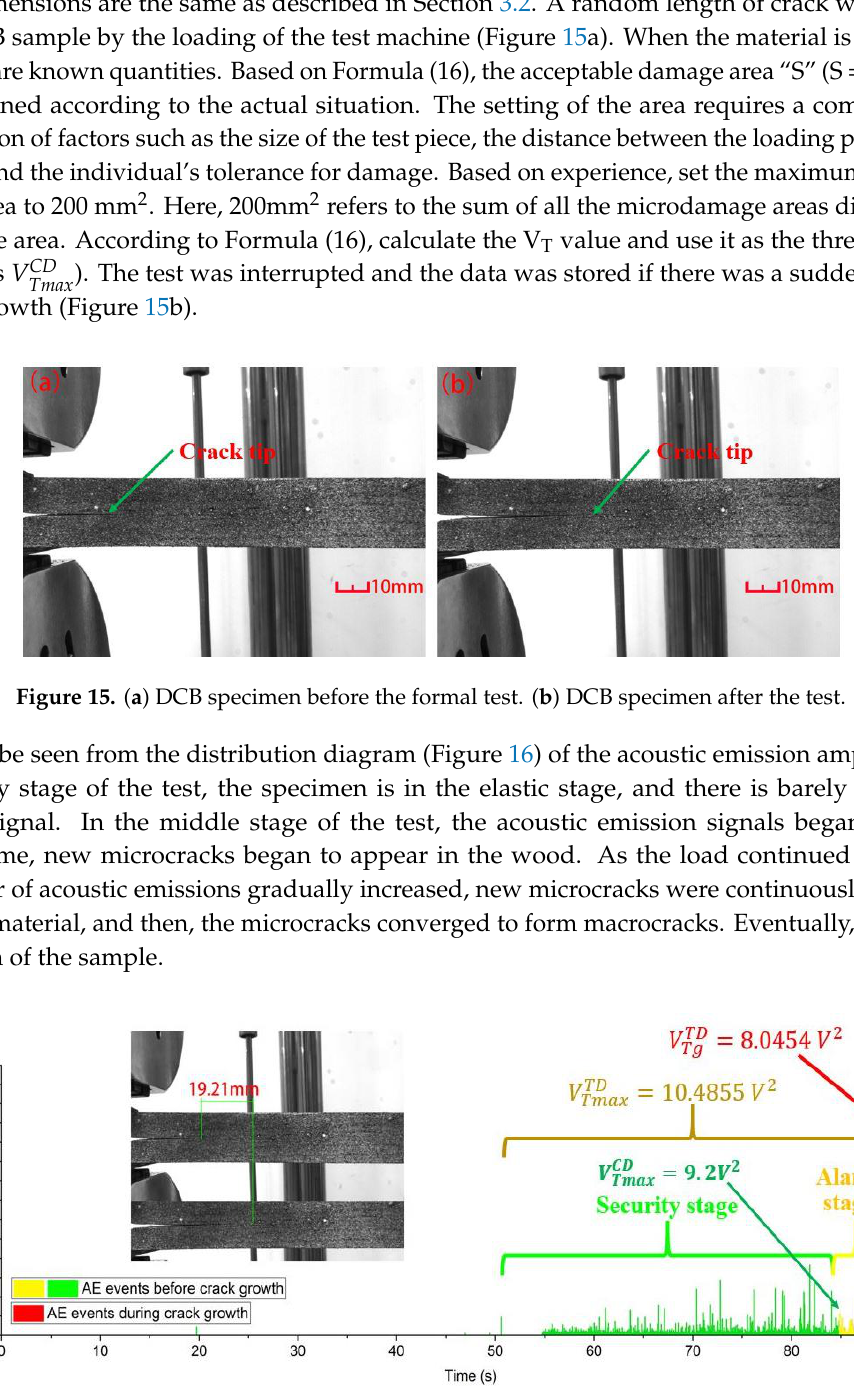
Figure 16. Acoustic emission amplitude-time distribution.